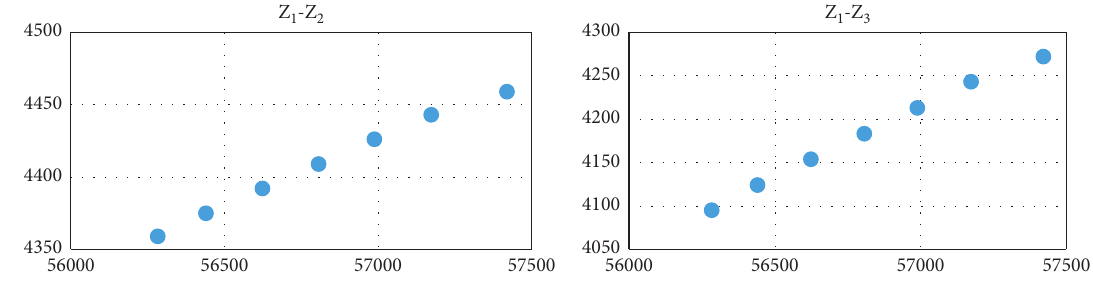
Figure 2: Pareto solutions of Z 1 - Z 2 and Z 1 - Z 3 . Table 10: Value of objective functions and supply portfolio using the SSP approach.